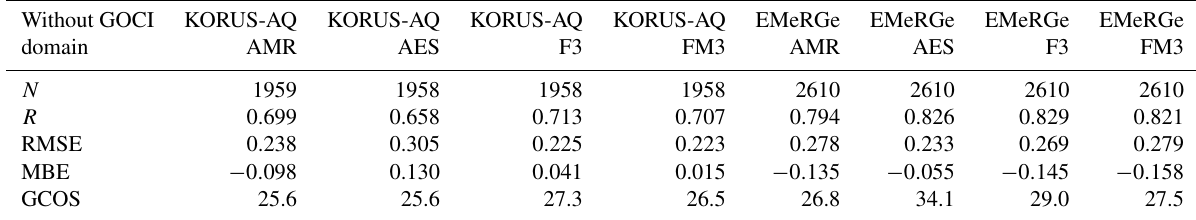
Table 4. Accuracy evaluation of outside of GOCI area of AMR, AES, F3, and FM3 AODs. Without GOCI KORUS-AQ KORUS-AQ KORUS-AQ KORUS-AQ EMeRGe EMeRGe EMeRGe EMeRGe domain AMR AES F3 FM3 AMR AES F3